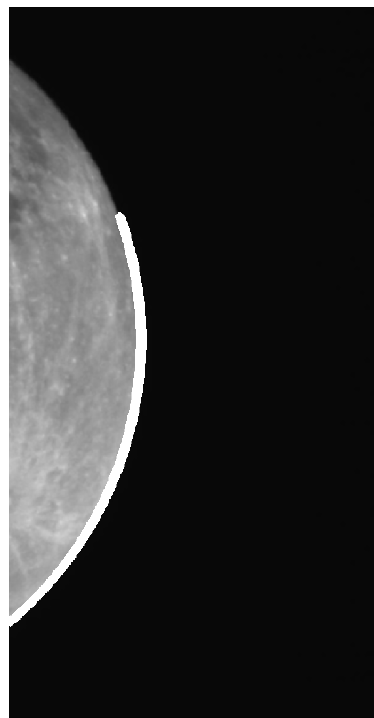
Figure 17. Example 3: CSF-LS final estimation (data in pixel). Center outside the image. Row center: 556.0114 ( ∆ r = − 4 . 1188 ). Column center: − 386.4042 ( ∆ c = − 6 . 6663 ). Radius: 605.5698 ( ∆ R = 7 . 233